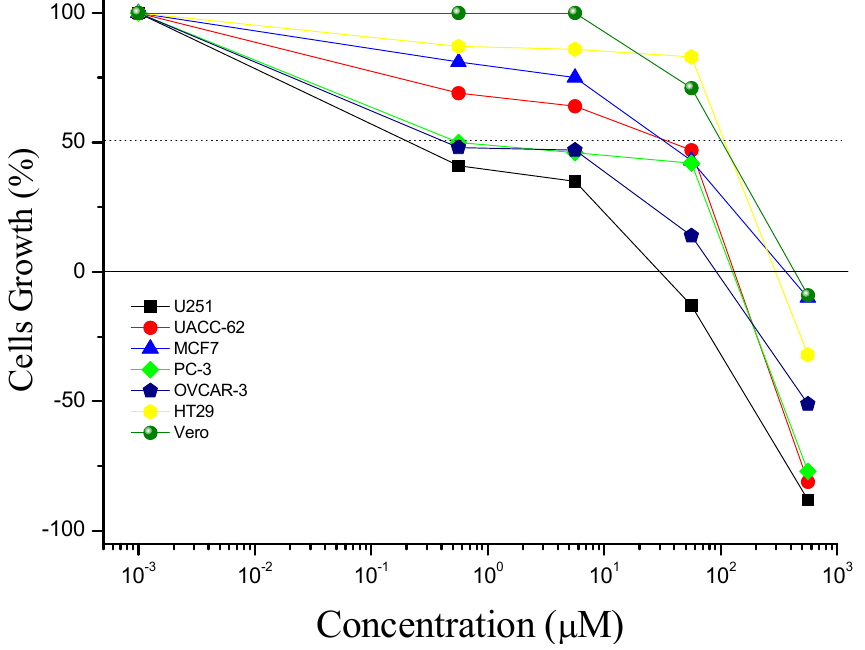
Figure 1. Concentration ( μ M) versus cell growth (%) for compound 11